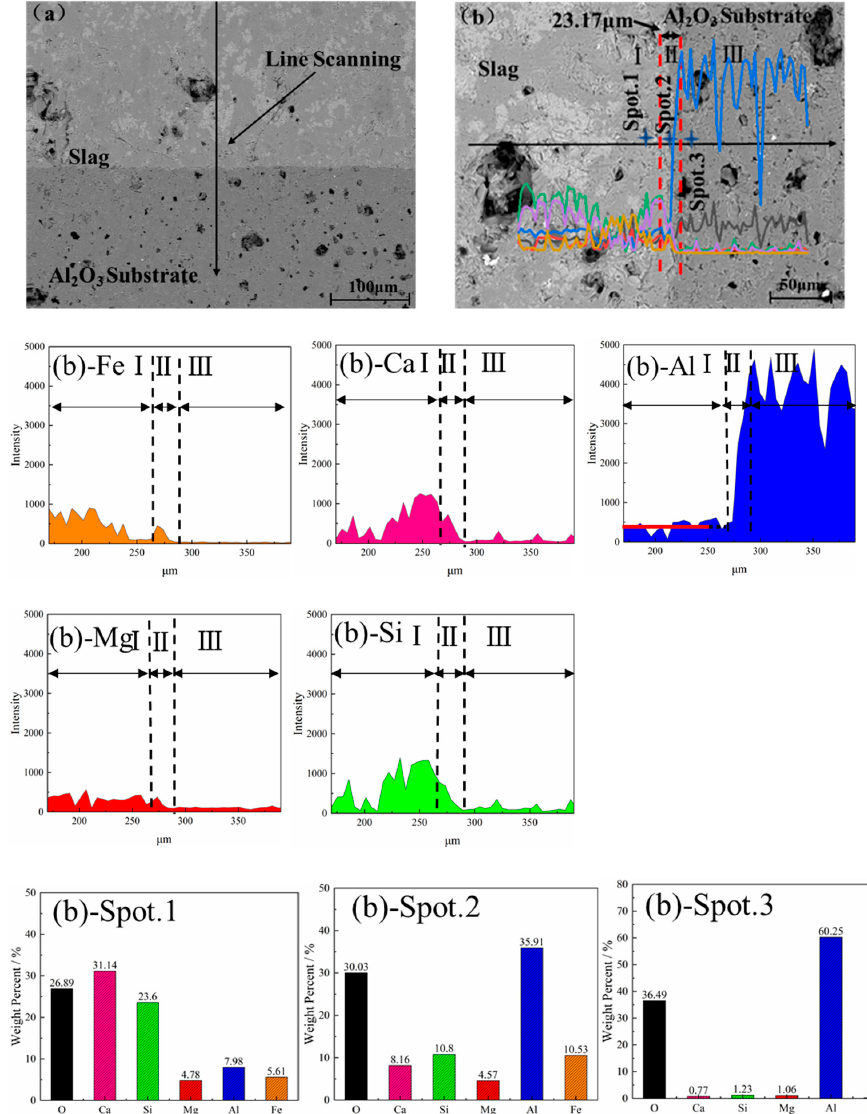
Figure 8. Line scanning results of slag B. Table 3. EDS composition at different locations.